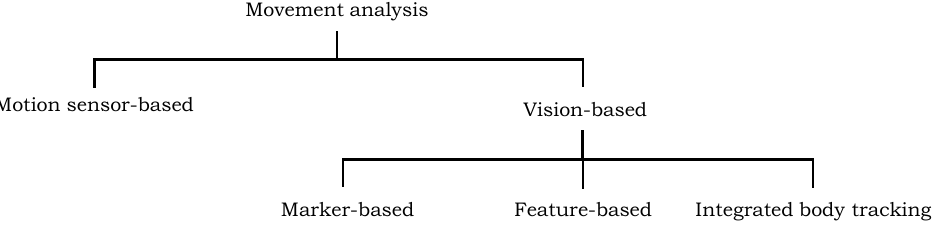
Figure 1. Categorization of existing techniques for movement analysis of human body parts into different